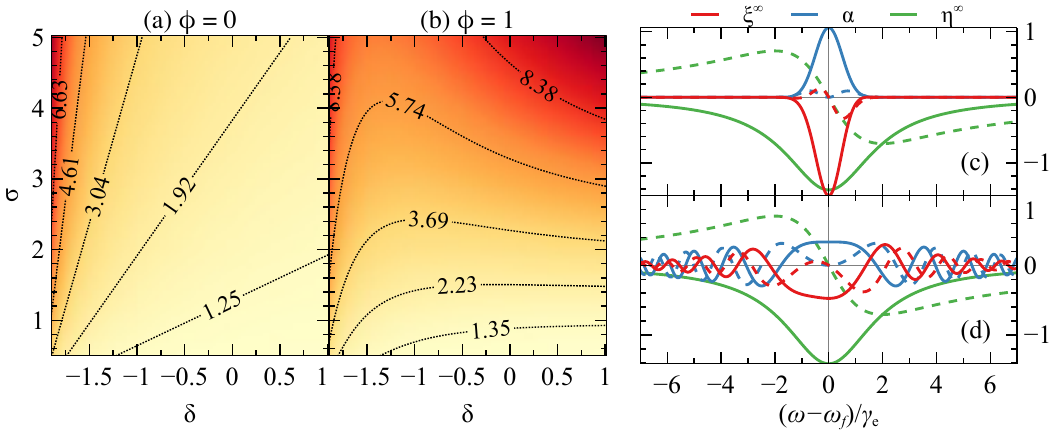
Figure 7: Left: Optimization ratio E (75), as a function of the deviation δ , obtained opt by shaping via (73) a pump pulse with a profile (76) of bandwidth σ . Panel (a) shows E for a quadratic phase φ = 0, while (b) for φ = 1. Right: Comparison of the opt one-photon distributions α (76), the integrated matter response function η ∞ (78), and their product ξ ∞ (77). Here ∆ = δ = 0, φ = 1 and, respectively, (c) σ = 0.5 and (d) σ = 5. Continuous (dashed) lines indicate the real (imaginary) parts of the